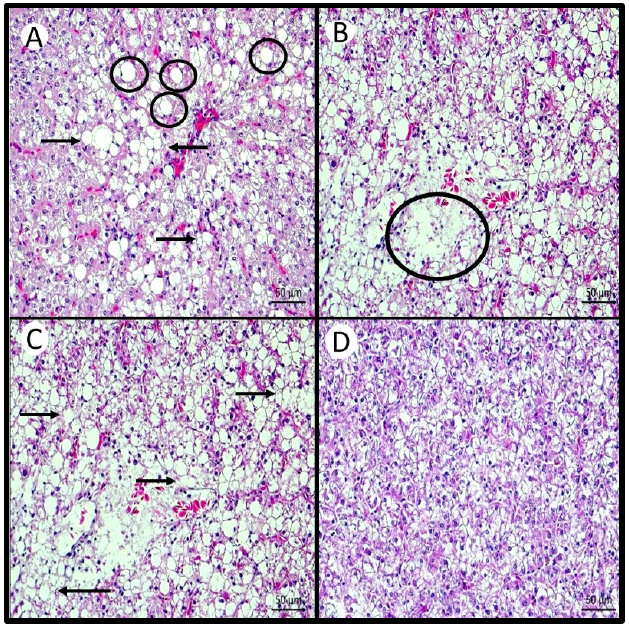
Figure 2. Histological changes in the hepatopancreas of Nile tilapia juveniles fed different levels of Aurantiochytriu m sp. meal (AM) or a cod liver oil (CLO) ‐ supplemented diet for 87 days, at 22 °C. ( A , B ) High intensity of macrosteatosis (circle) and microsteatosis (arrow) in fish fed the 0AM diet. ( B ) High intensity of necrosis (circle) in fish fed the 0AM diet. ( C ) High loss of hepatocyte nucleus (arrow) in fish fed the 0AM diet. ( D ) Smaller variation in hepatocyte size in the hepatopancreas and lower intensity of macrosteatosis, microsteatosis, and necrosis in fish fed the 40AM